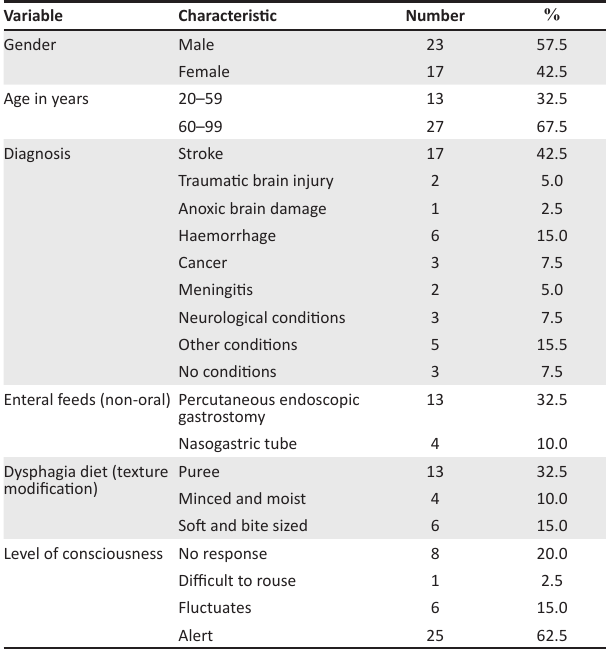
TABLE 1: Demographic details of participants who presented with dysphagia ( N = 40).